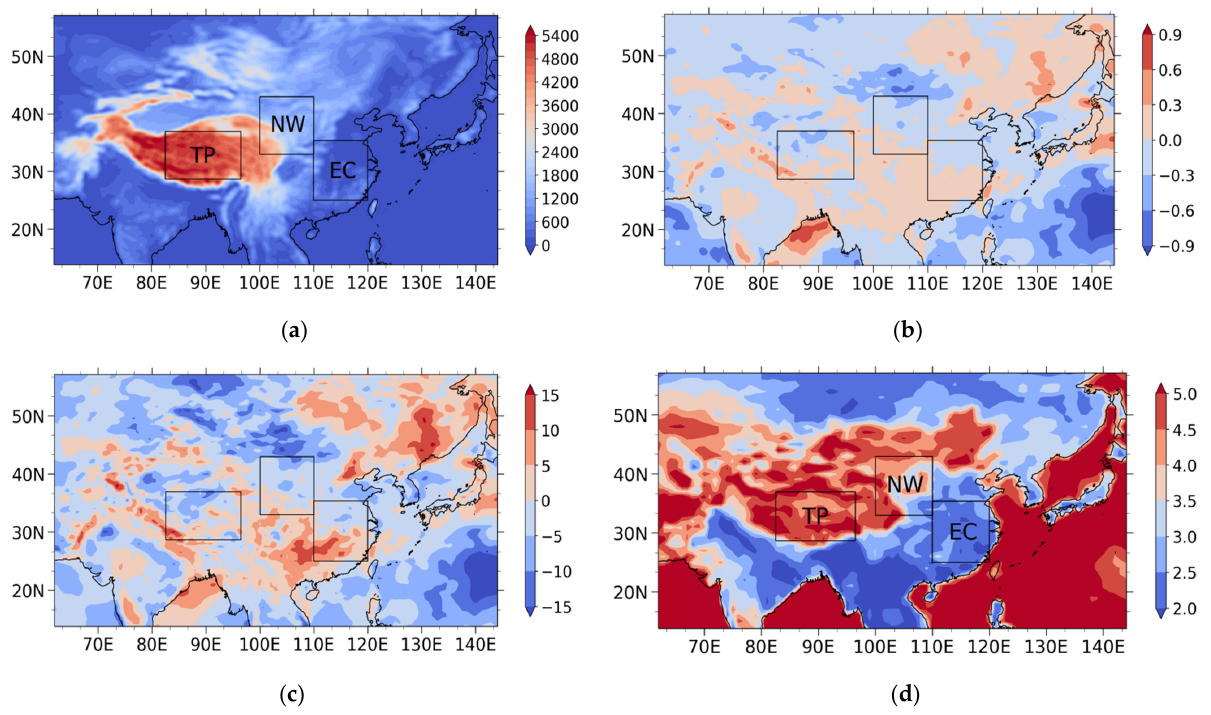
Figure 1. The studied domain and its 10 m wind speed distributions. ( a ) The terrain of the simulation domain (unit: m) and distribution of the studied sub-regions (i.e., Northwest China, NW; East China, EC; and the Tibetan Plateau, TP); ( b ) the distribution of the wind speed anomaly during the summer of 2003 (units: m s − 1 ); ( c ) the distribution of the wind speed anomaly in percentage in the summer (unit: %); ( d ) the seasonal mean wind speed of FNL analysis [13].